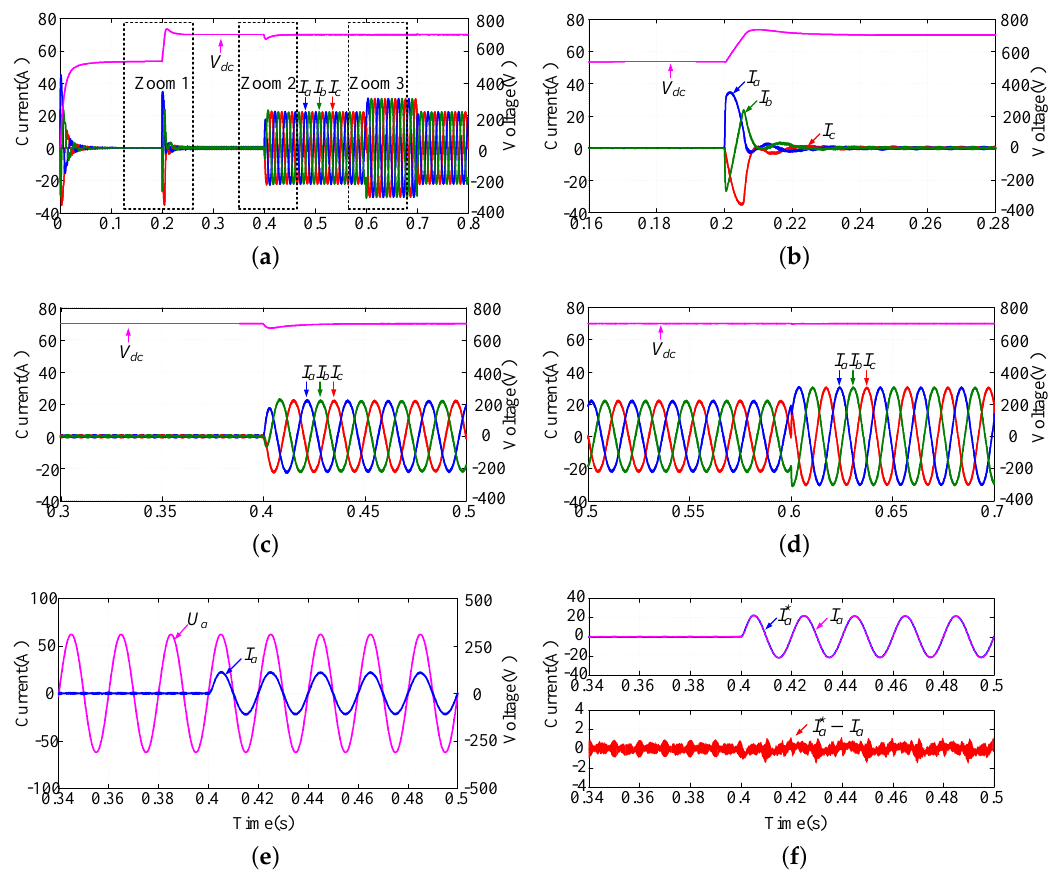
Figure 13. Simulation results of the proposed control strategy: ( a ) general view of the DC-link capacitor voltage and three-phase grid current; ( b ) three-phase grid current when the GC-VSC operates in the state of PWM rectifier; ( c ) three-phase grid current when 10 kW active power is applied; ( d ) three-phase grid current when 10 kvar reactive power is added; ( e ) grid voltage and current of phase A when unity power control is implemented; and ( f ) reference current, actual current and current error of phase A when load